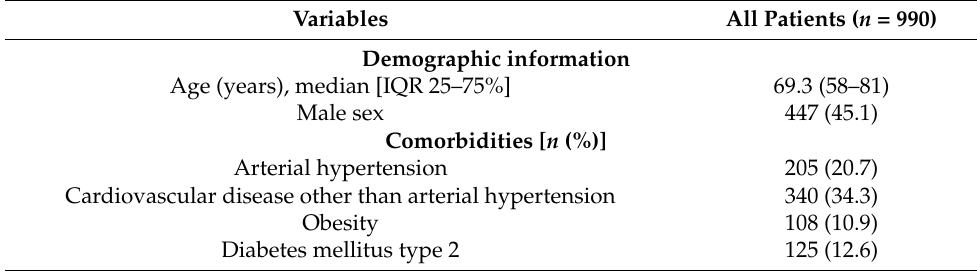
Table 1. Baseline characteristics of study